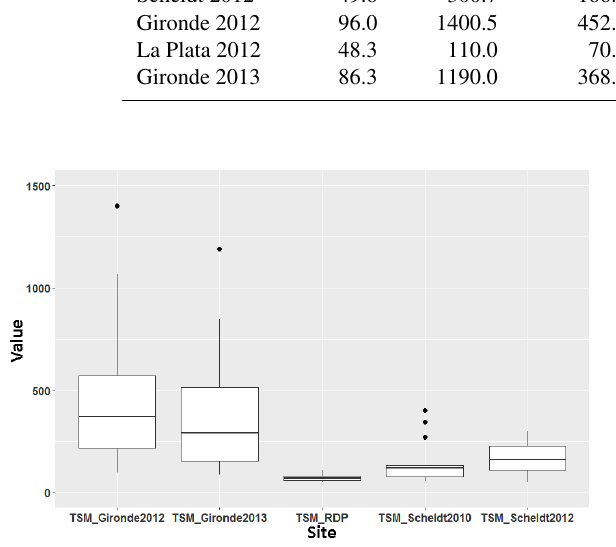
Figure 8. Boxplot for TSM for all sites.